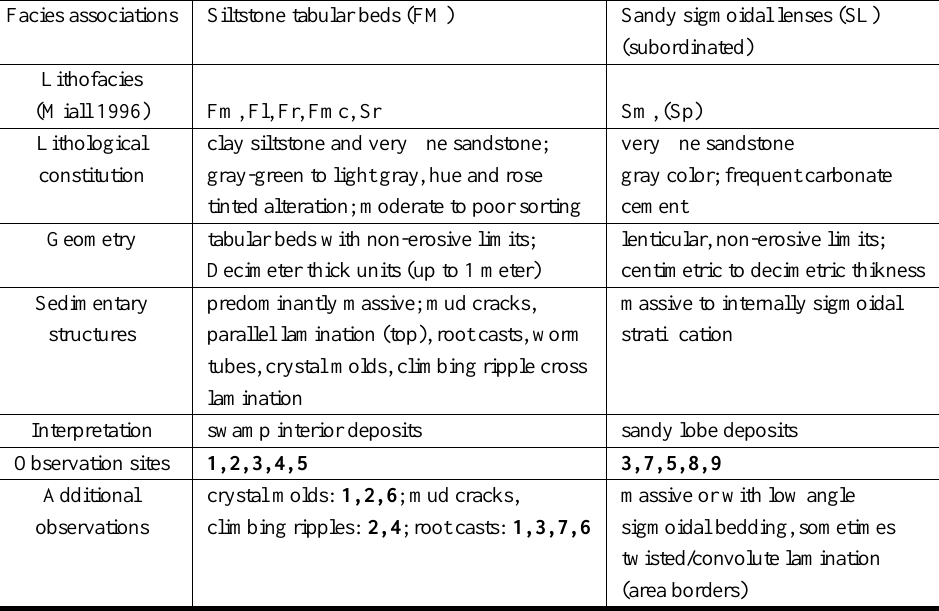
Lithofacies associations of the Araçatuba Formation (After Fernandes